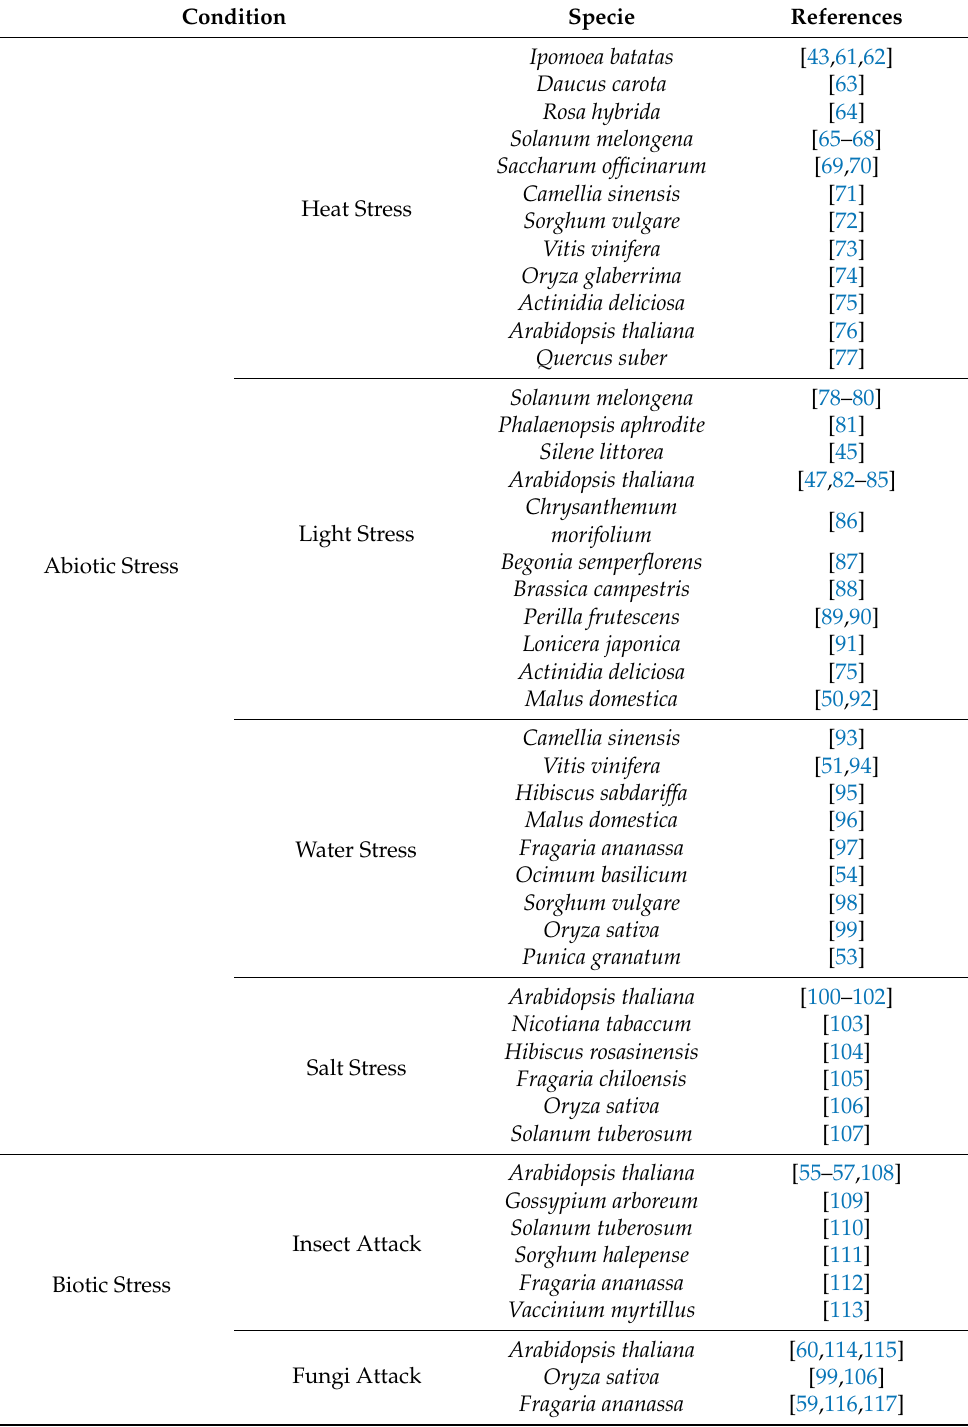
Table 1. Documented plant responses to abiotic and biotic stresses that involves